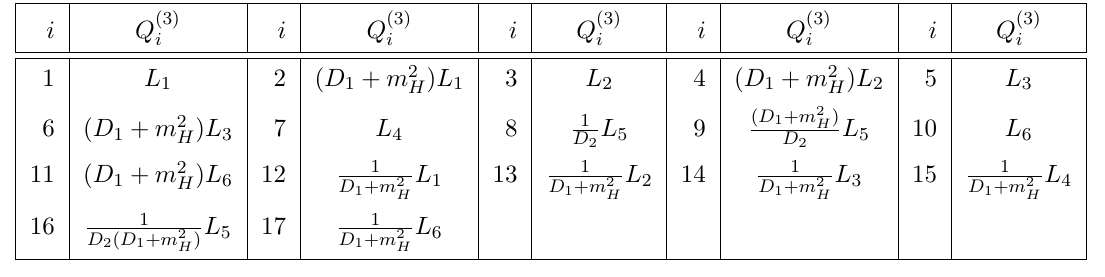
expressed in terms of the denominator factors from eq. (E.1) and the integrals L Table 2 . Q (3) i from eqs. (3.16) and (3.19).